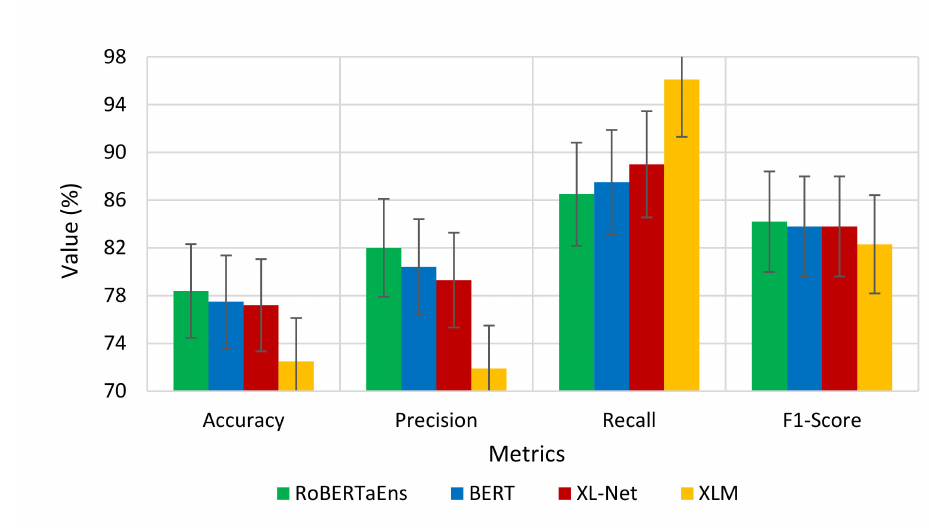
Figure 5. Performance of RoBERTaEns and other Transformer models.